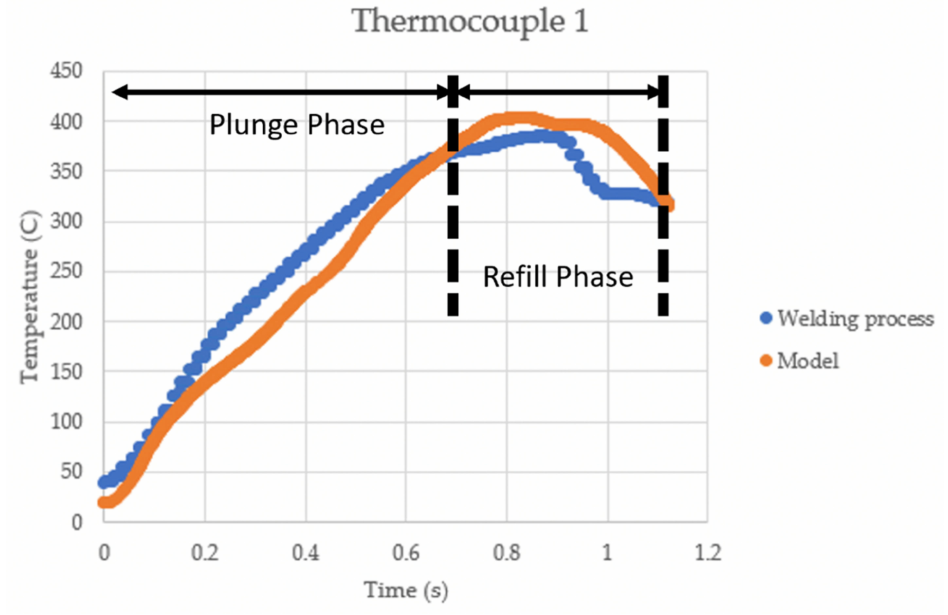
Figure 8. Temperature comparison for Thermocouple 1.